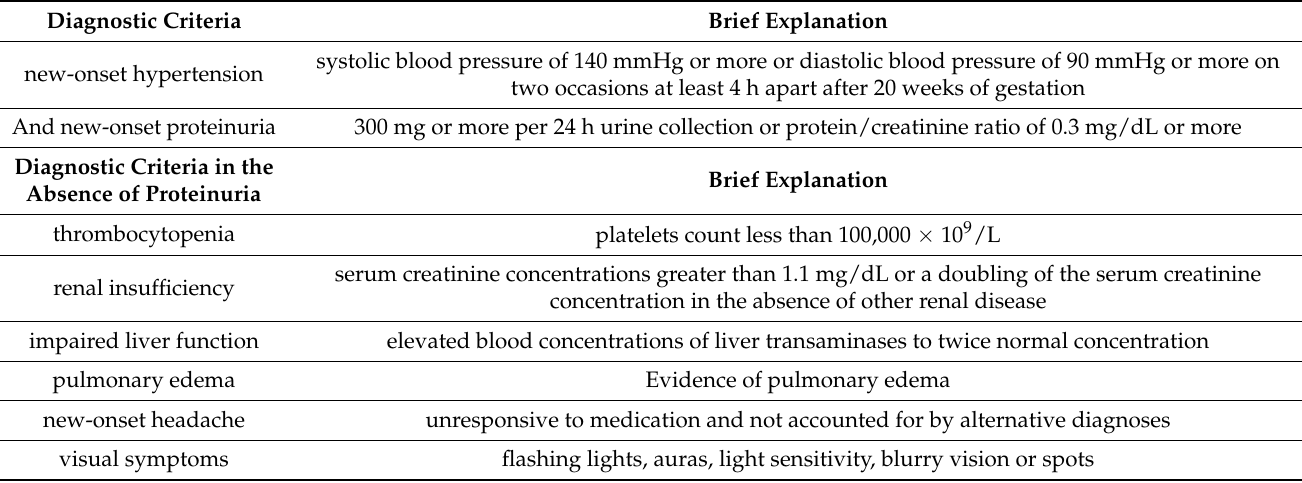
Table 1. Diagnostic criteria of preeclampsia